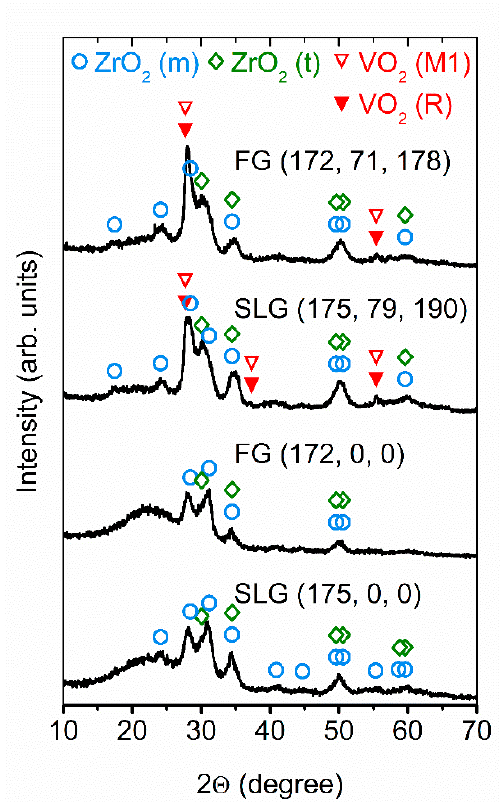
Figure 5. X-ray diffraction patterns taken at T m = 25 °C from the ZrO 2 (172 nm)/V 0.984 W 0.016 O 2 (71 nm)/ZrO 2 (178 nm) coating on 0.1 mm thick FG substrate and the ZrO 2 (175 nm)/V 0.984 W 0.016 O 2 (79 nm)/ZrO 2 (190 nm) coating on 1 mm thick SLG substrate. For comparison, the X-ray diffraction patterns from the corresponding ZrO 2 layers with the thickness h b = 172 nm and 175 nm are given. The main diffraction peaks of VO 2 (R), VO 2 (M1), ZrO 2 (m) and ZrO 2 (t) are marked.